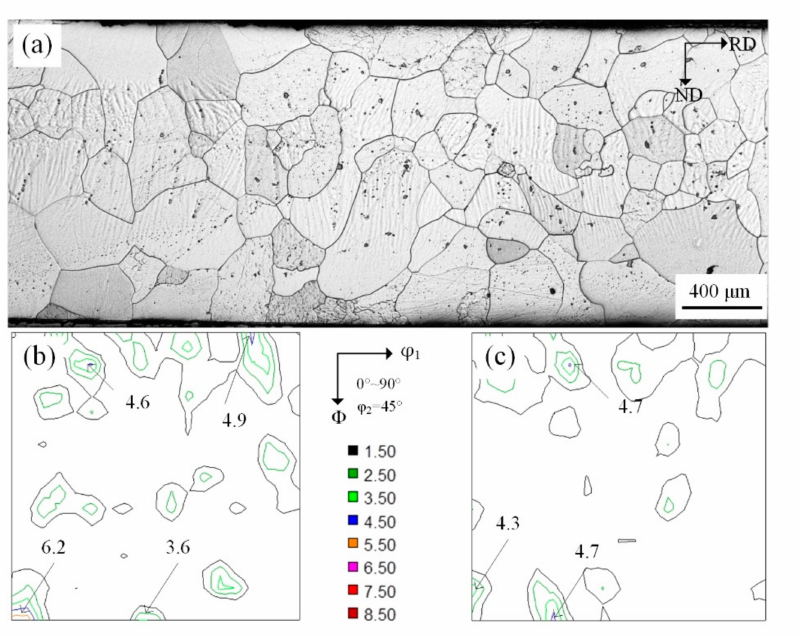
Figure 2. Microstructure ( a ) and constant ϕ 2 = 45 ◦ sections of ODF at S = 7/8 ( b ) and S = 1/2 ( c ) of the Fe-1.3% Si cast